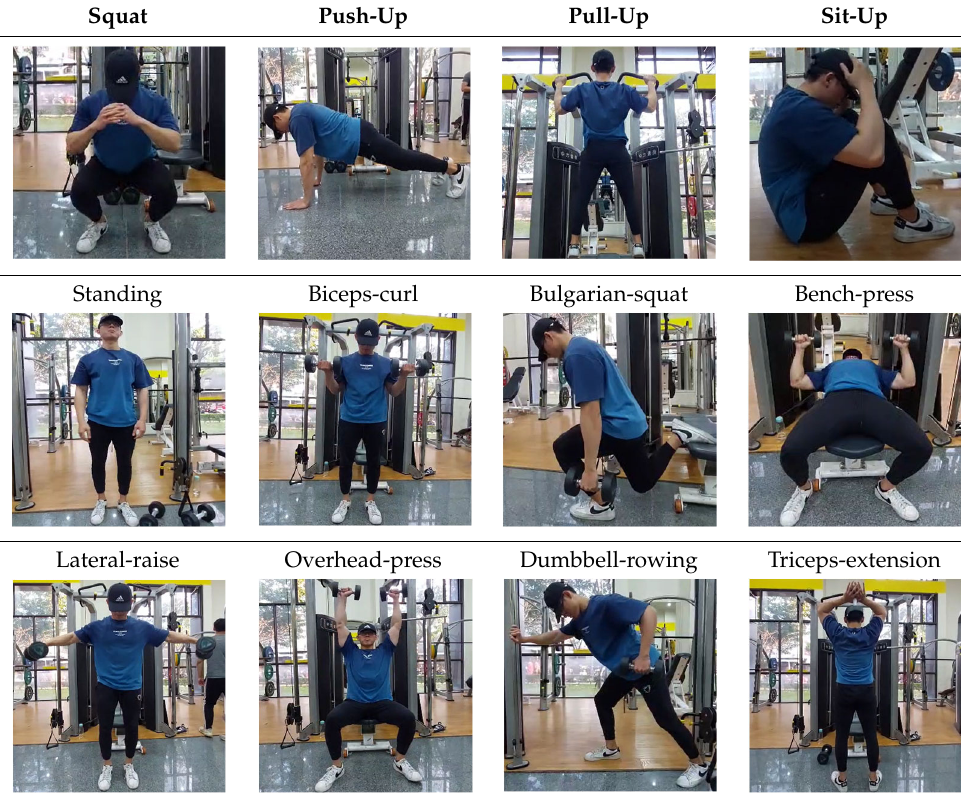
Figure 1. Method flowchart.